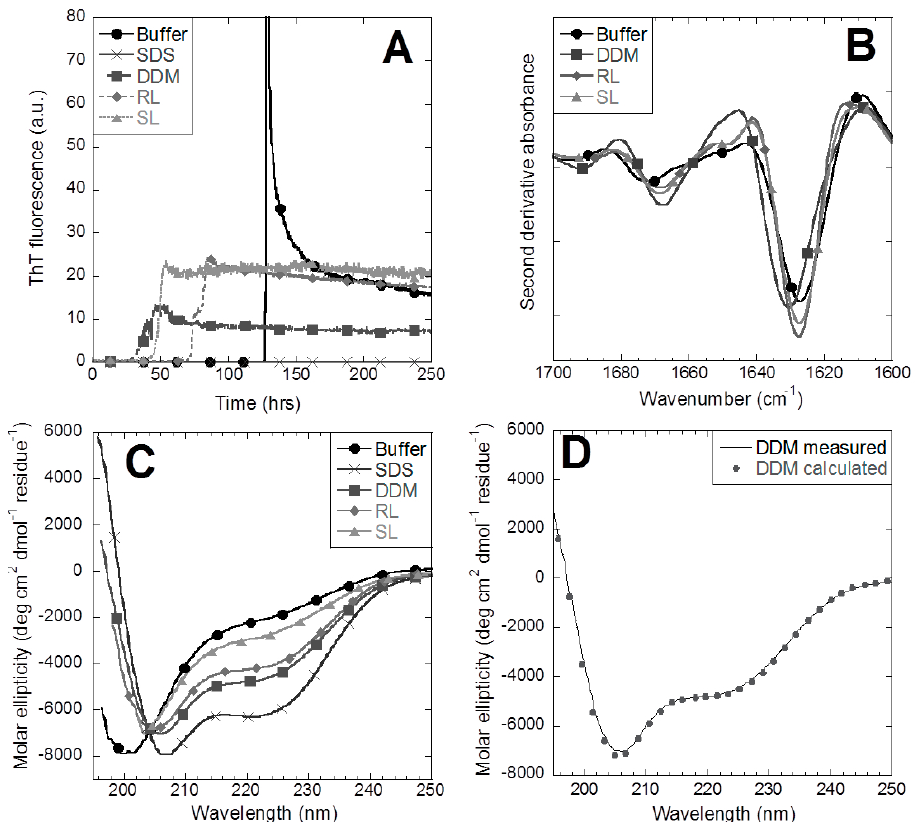
Figure 1. Amyloidogenic propensity of 3474 in buffer and surfactants. ( A ) Incubation of 3474 at 40 °C under constant agitation and monitoring amyloid formation, using the amyloid dye ThT, shows that fibrillation of 3474 is accelerated by the addition of dodecyl maltoside (DDM), rhamnolipid (RL), and sophorolipid (SL), while sodium dodecyl sulphate (SDS) inhibits aggregation completely. ( B ) FTIR confirms the amyloid peak of 3474. ( C ) The far-UV circular dichroism signal of 3474 before aggregation shows increasing α -helicity with surfactants. ( D ) Comparison of measured circular dichroism (CD) structure and the calculated signal of 3474-DDM based on linear combinations of its structure in buffer and SDS.